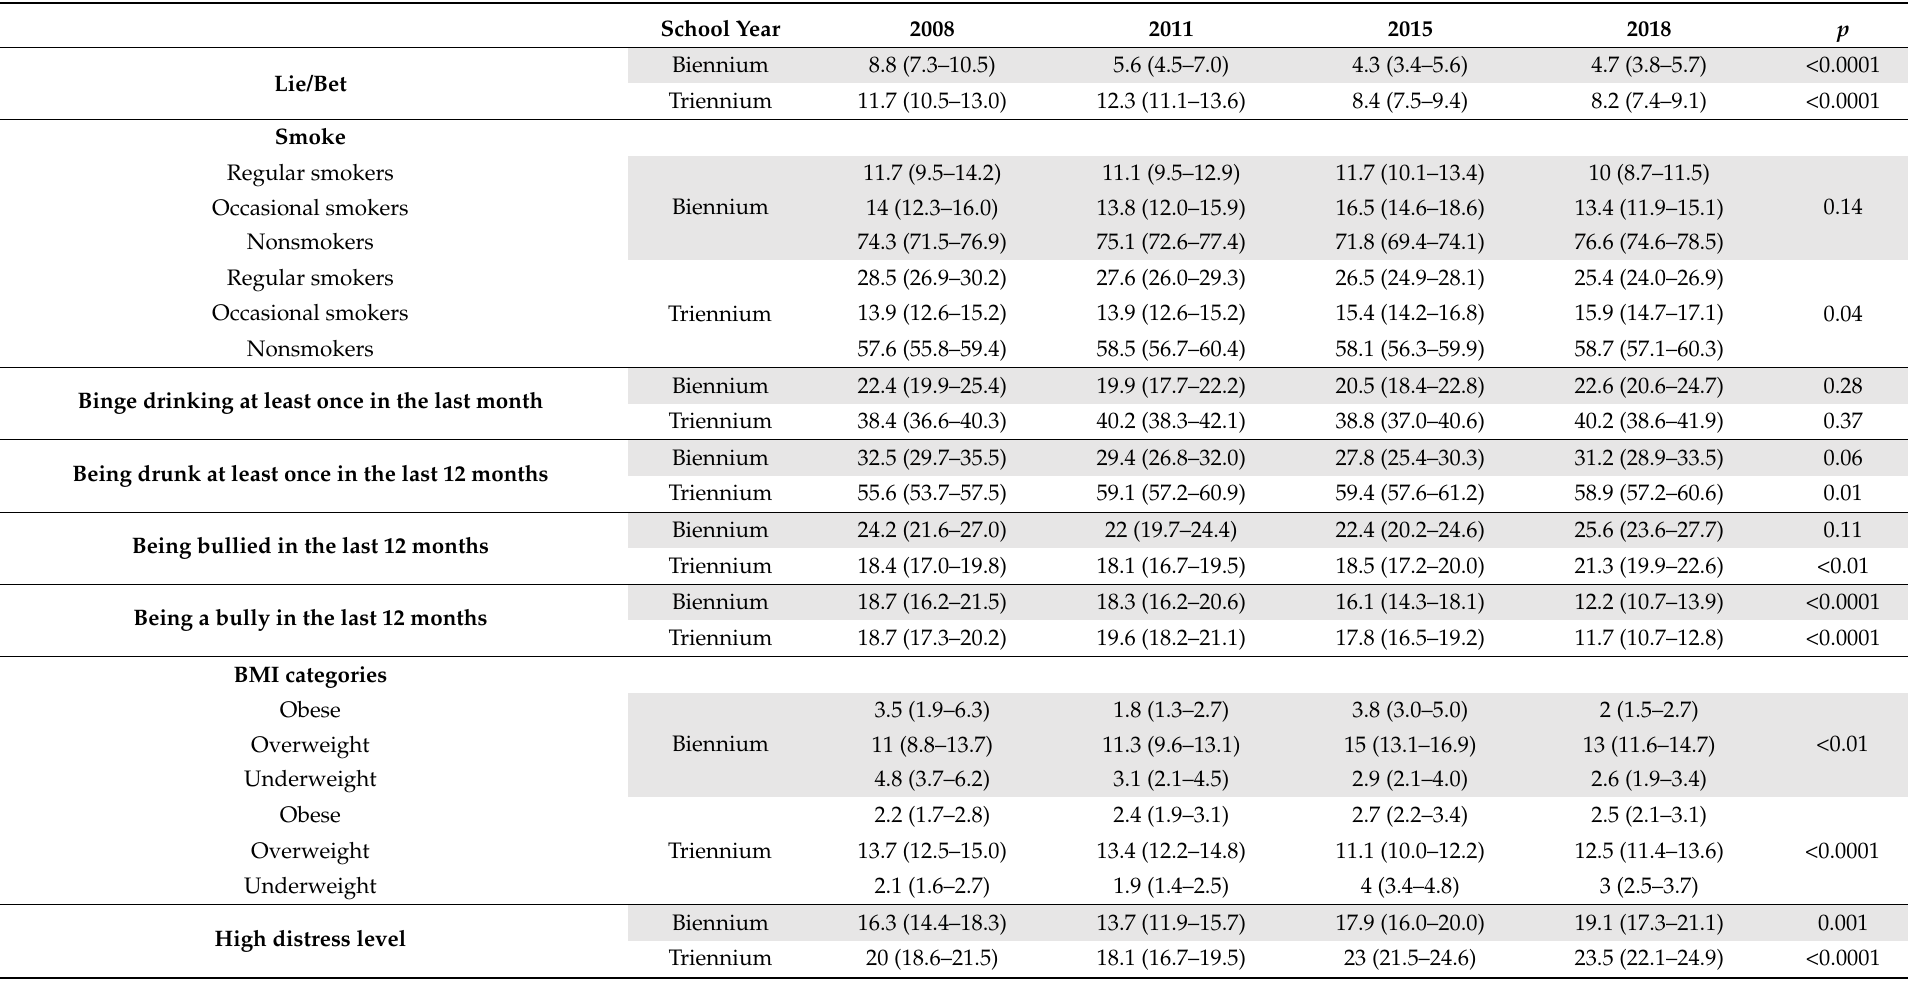
Table 4. Trends of the prevalence of health risk behaviors and health conditions by high–school years (survey waves 2008, 2011, 2015, and